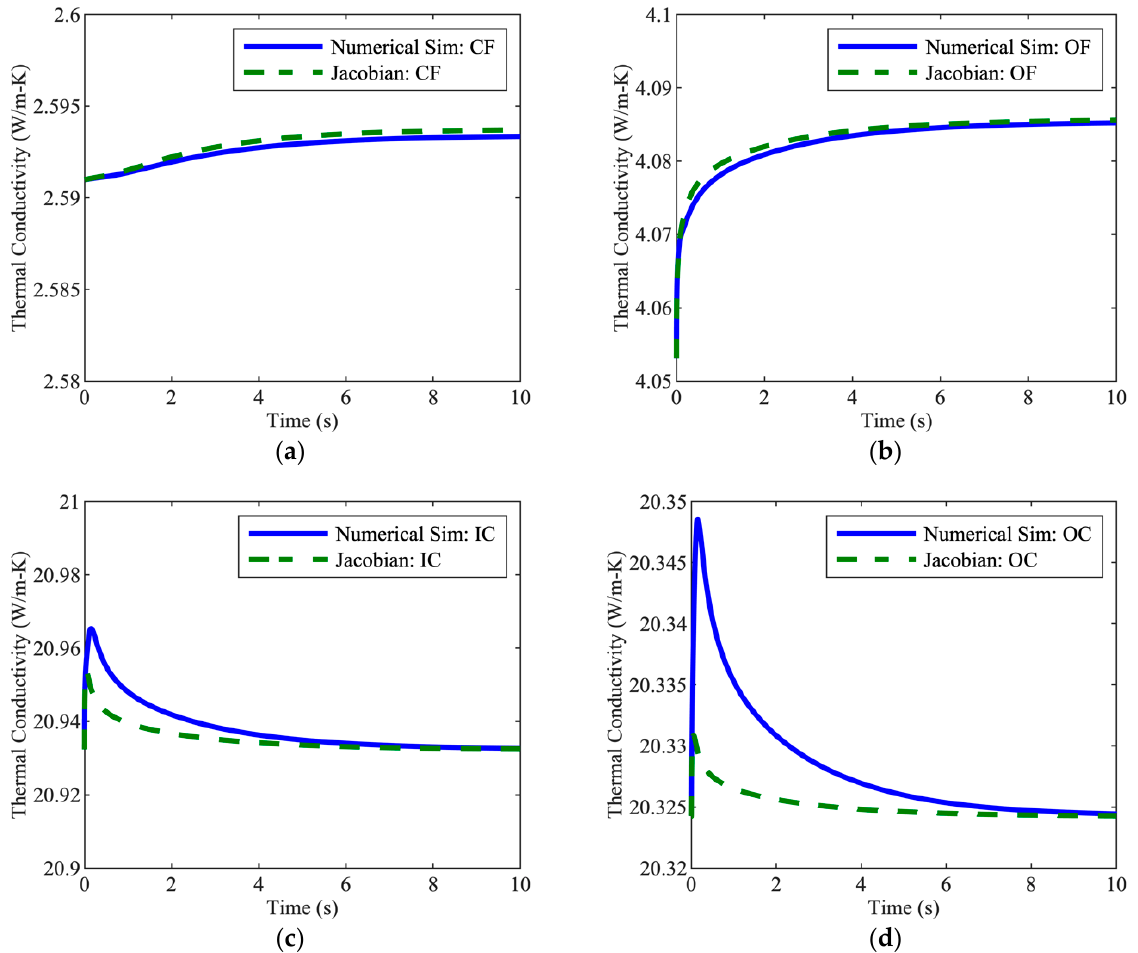
Figure 7. Thermal conductivity evolutions at various radial positions (CF = centerline fuel, OF = outer fuel, IC = inner cladding, and OC = outer cladding) during the 1% all-fuel temperature perturbation. ( a ) Thermal conductivity evolution at the fuel centerline node. ( b ) Thermal conductivity evolution at the outer fuel node. ( c ) Thermal conductivity evolution at the inner cladding node. ( d ) Thermal conductivity evolution at the outer cladding node.